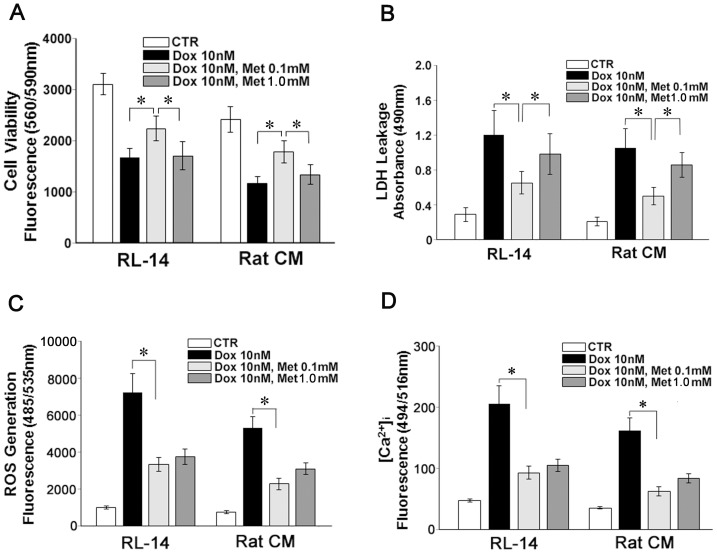
Effects of Met on Dox induced cytotoxicity in RL-14 human cardiomyocytes and rat primary cardiomyocytes.RL-14 human immortalized fetal cardiomyocytes and rat neonatal primary cardiomyocytes (Rat CM) were cultured with same conditions as we did for H9c2 cells, and (A) cell viabilities, (B) LDH leakages, (C) ROS generations and (D) [Ca2+]i were evaluated at 72 hour, 24 hour, 6 hour and 90 minute, respectively. Values represent mean ± S.D. (n = 4) from quadruplicate samples for each treatment at varying treatment conditions. * p<0.05.